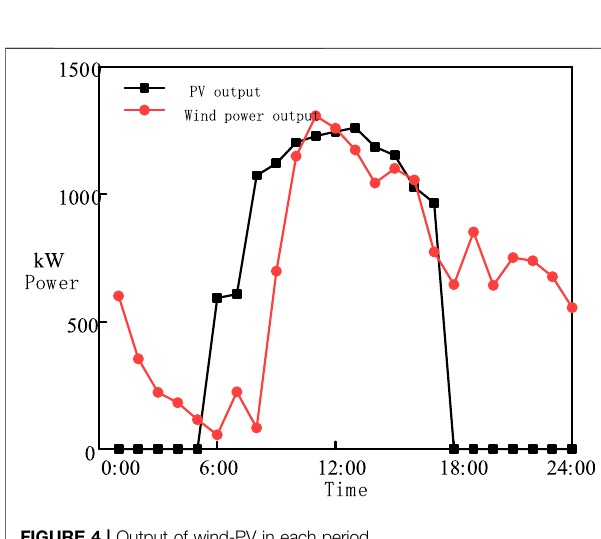
FIGURE 3 | Photovoltaic power distribution parameters α and β and wind speed distribution parameters c w and k w .